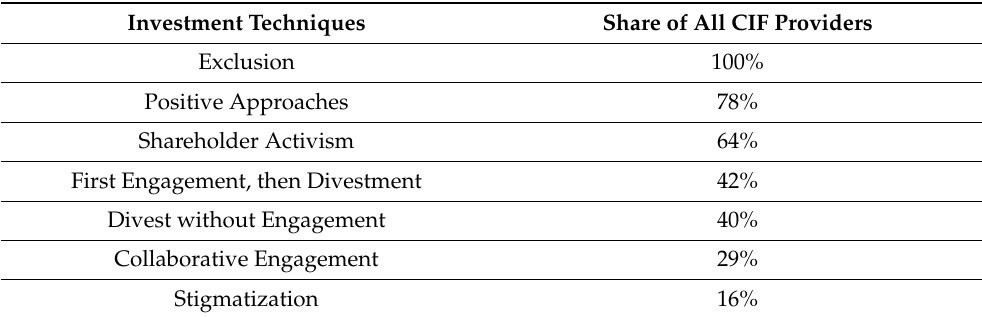
Table 5. Key techniques for an ethical investment strategy of a CIF